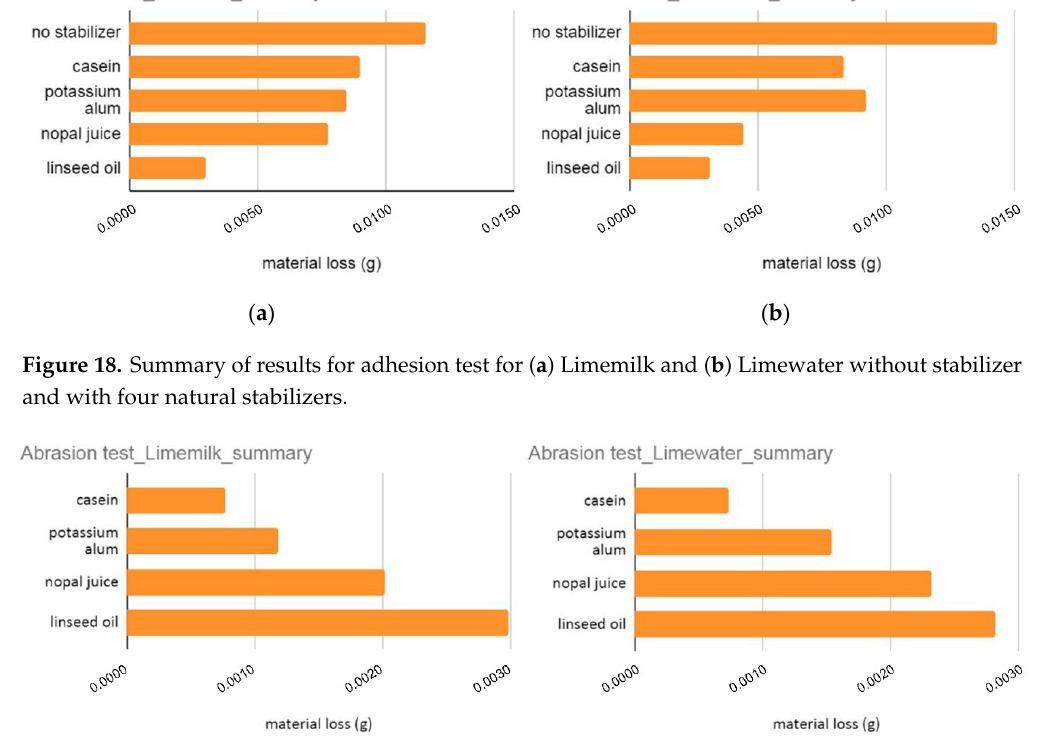
Figure 18. Summary of results for adhesion test for ( a ) Limemilk and ( b ) Limewater without stabilizer and with four natural stabilizers.